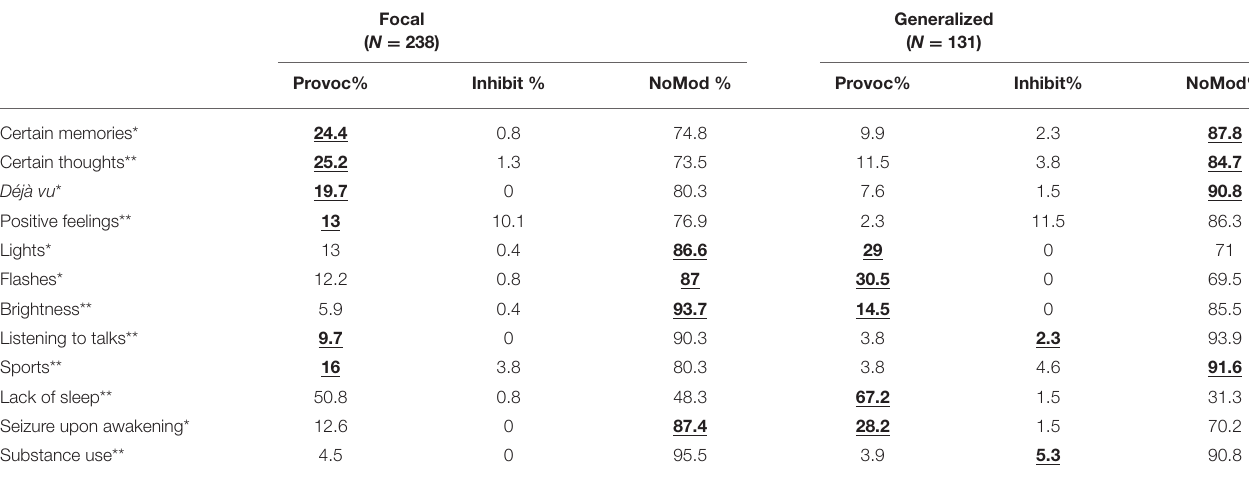
TABLE 5 | Modulatory factors with significant difference between focal and generalized epilepsy.